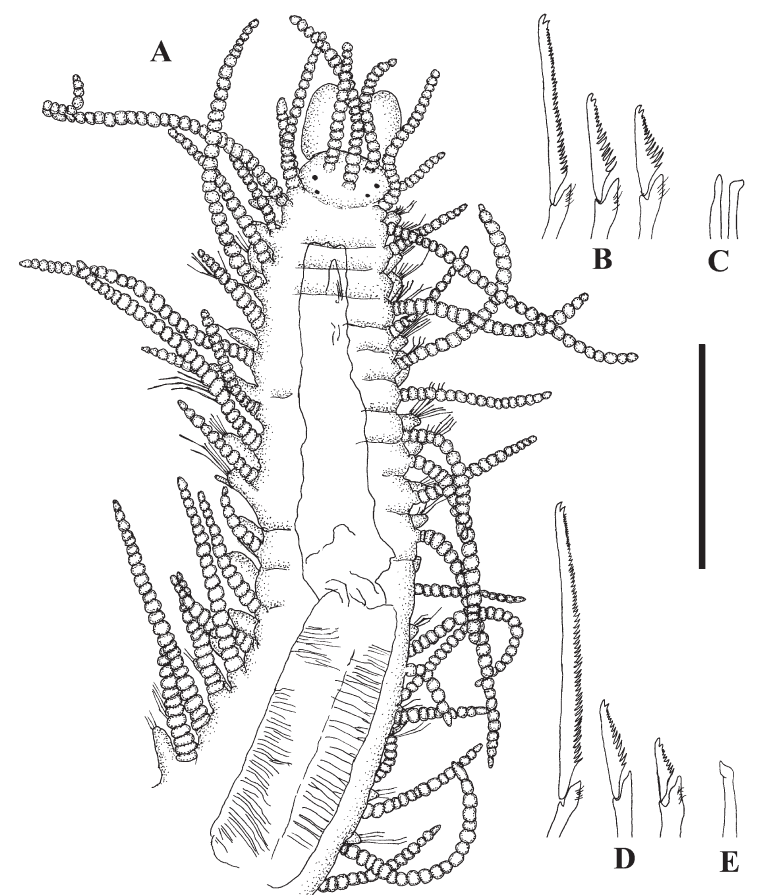
Fig . 7. – Syllis beneliahuae . A, anterior end, dorsal view; B, anterior pseudospiniger and falciger chaetae; C, mid-body aciculae; D, mid- posterior pseudospiniger and falciger chaetae; E, posterior aciculae. Scale bars: A, 500 µm; B-E, 50